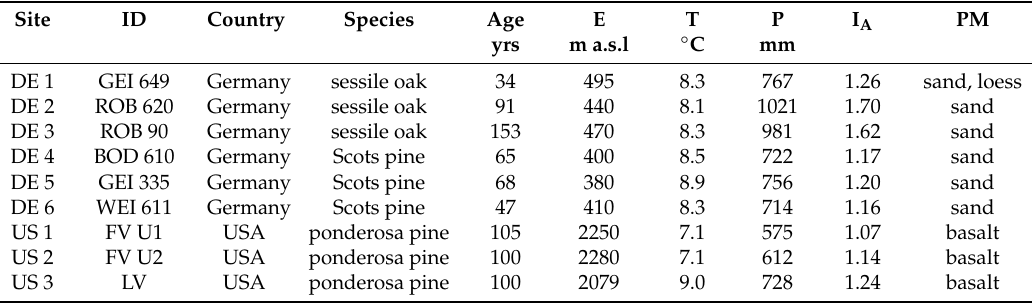
Table 1. Site and stand characteristics for all nine locations studied in Bavaria, Germany (DE 1–DE 6) and Arizona, USA (US 1–US 3). Age : stand age. E : elevation. T : mean annual temperature. P :